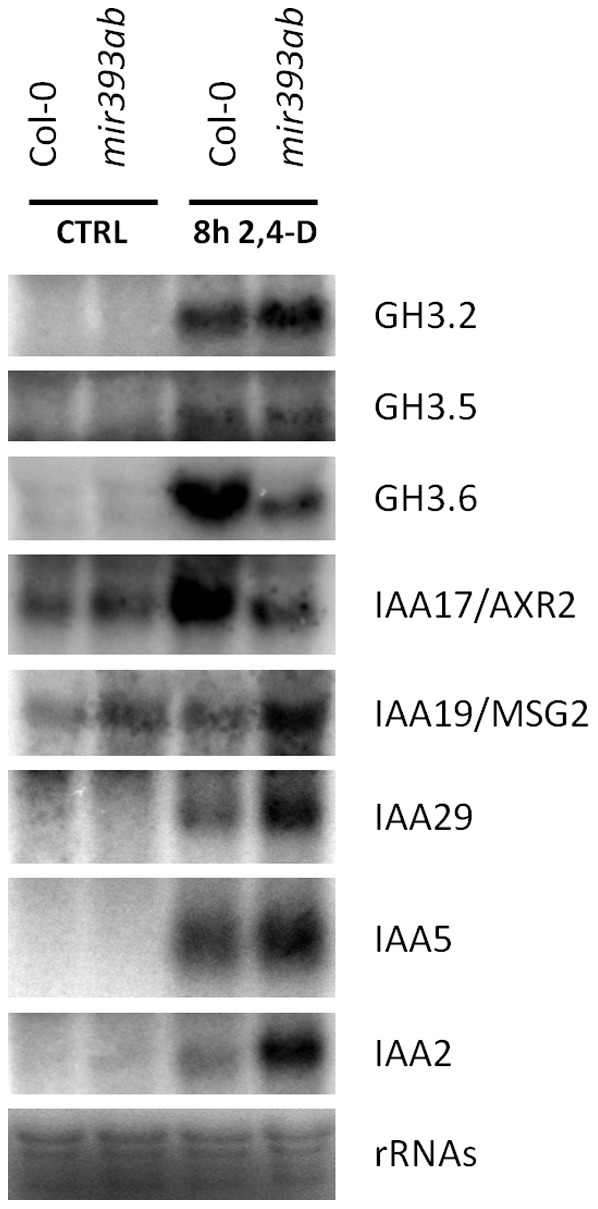
miR393 is required for proper induction of AUX/IAA and GH3 genes.Northern blots of RNAs from wt and mir393ab mutant plantlets treated or not with 10 µM 2,4-D for 8 h. Without treatments, IAA17 and IAA19 have higher steady state levels in mir393ab mutants than in wt plants. Treatment with 2,4-D for 8 h induces the expression of all genes tested. GH3.5 accumulates to similar levels in wt and mutants, GH3.2, IAA19, IAA29, IAA5 and IAA2 accumulate to higher levels in mir393ab mutants than in wt plants while GH3.6 and IAA17 accumulate to lower levels in mir393ab mutants than in wt plants.